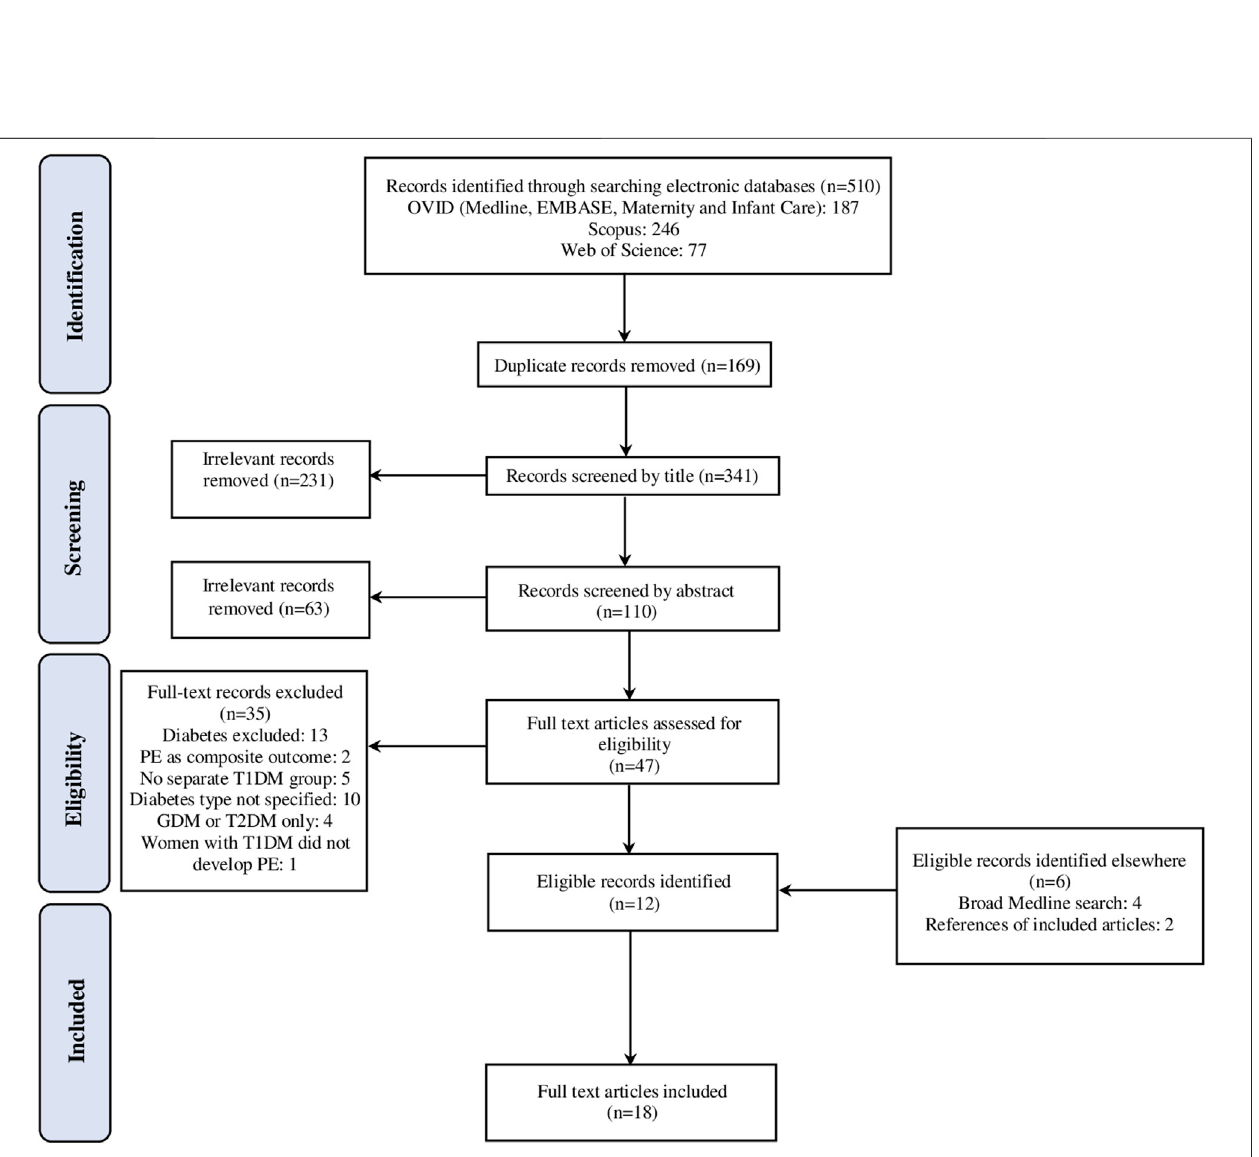
FIGURE 1 | The Preferred Reporting Items for Systematic Reviews and Meta-Analyses (PRISMA) fl ow diagram of the study selection